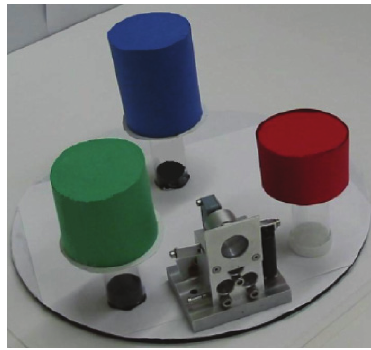
Figure 9: Three cylindrical-shaped color objects are used as the beacons, and the female connector is fixed on the origin of the target frame.